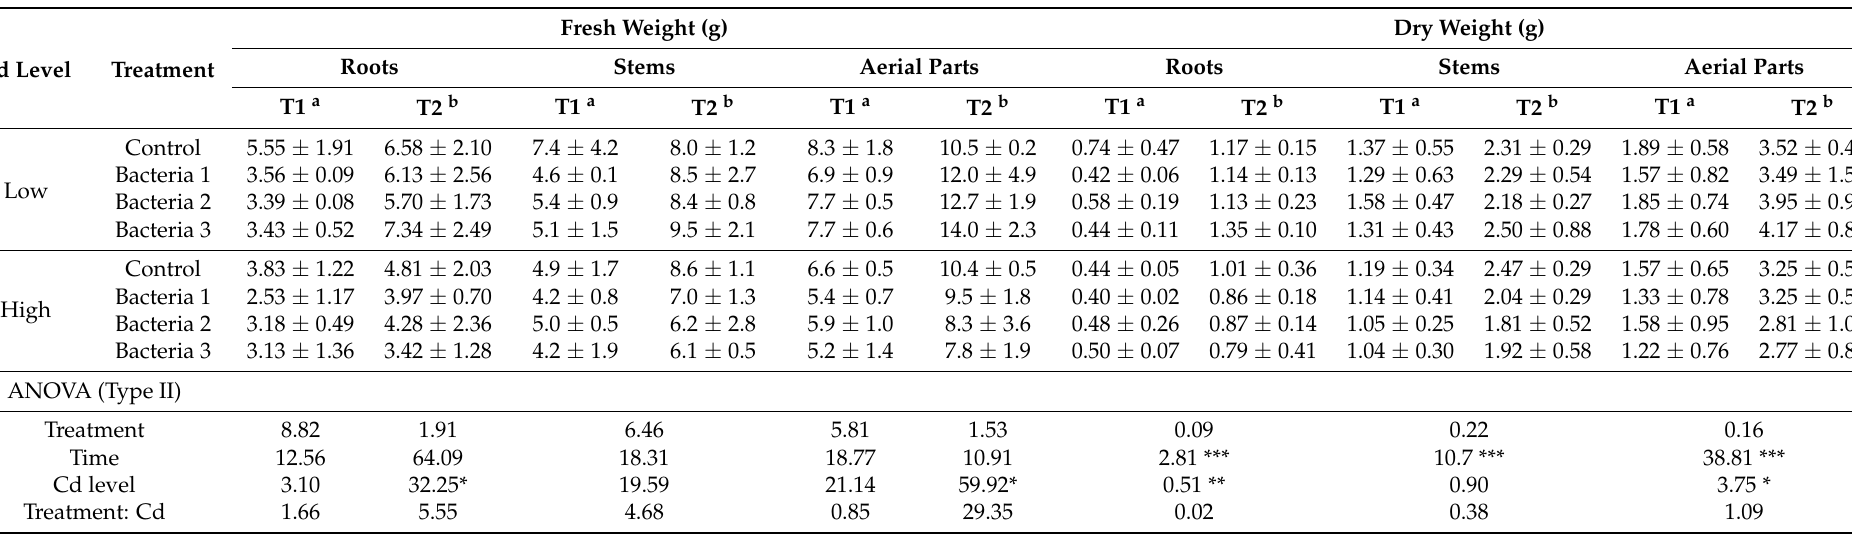
Table 5. Effects of the bacterial inoculation (control, not inoculated; bacteria, inoculated seedlings) on morphological and physiological parameters of cocoa